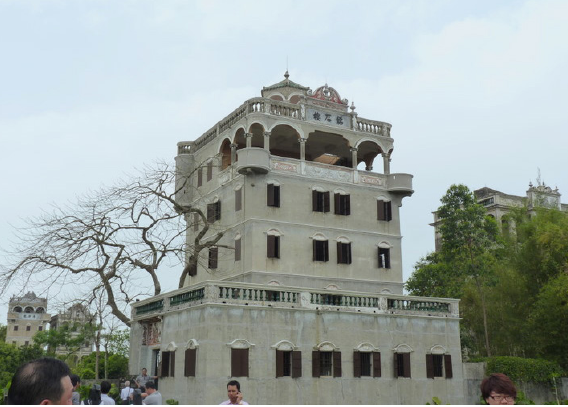
Figure 1. Architectural style of Diaolou (source: field survey)